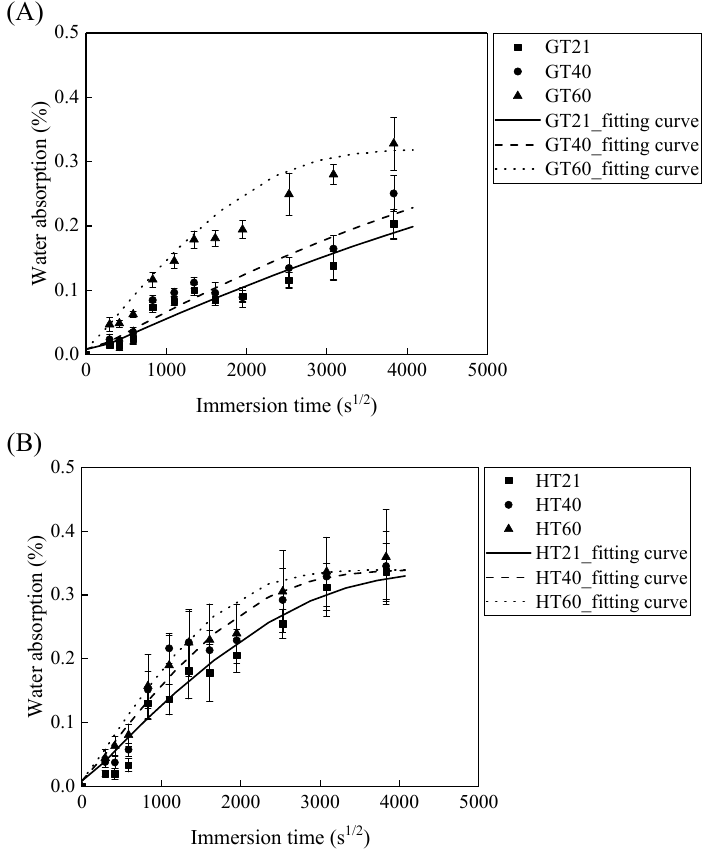
Table 1. The diffusion coefficient and saturation water absorption of the FRP bars fitted by the Equation (2).